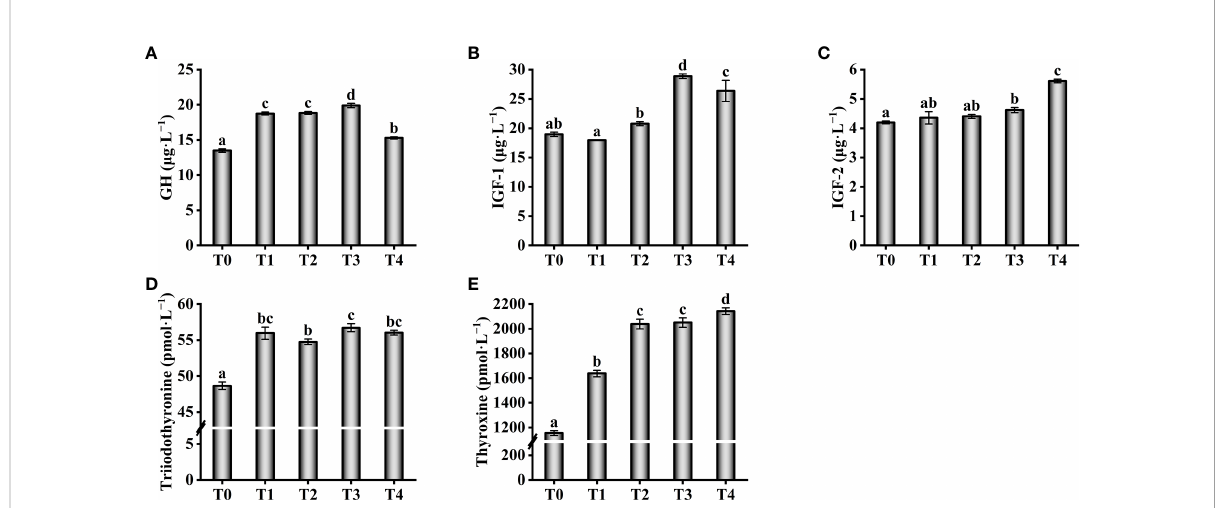
FIGURE 2 Effect of growth-related parameters such as GH (A) , IGF-1 (B) , IGF-2 (C) , Triiodothyronine (D) and Thyroxine (E) in the serum of T. ovatus fed diets with different dose taurine supplementation after 8 weeks. Mean values (n = 9) within values in the picture above with different superscripts are signi fi cantly different ( P < 0.05).